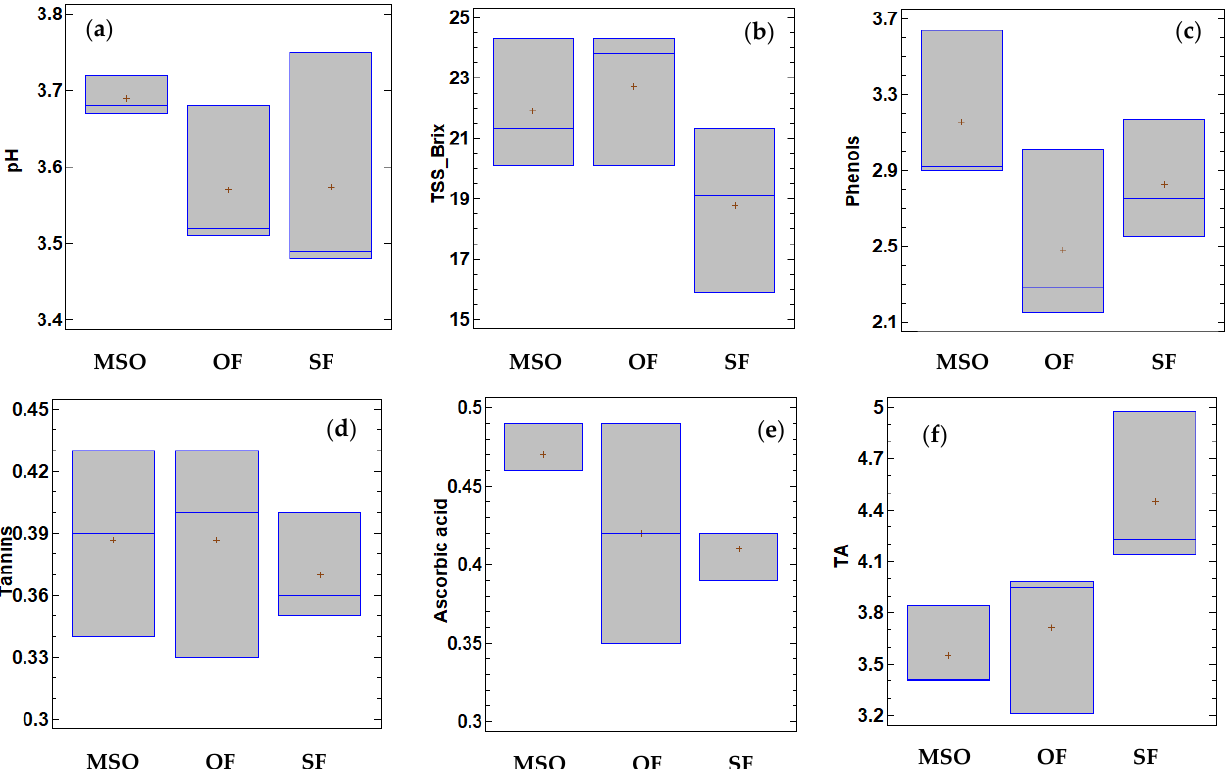
Figure 3. Grape qualitative characteristics for the three treatments. ( a ) pH, ( b ) Total Soluble Solids—TSS (°Brix), ( c ) Total phenolic content (g GAE g −1 fw), ( d ) condensed tannins (g L −1 ), ( e ) Ascorbic acid (mg AA/100 mL), ( f ) Titratable Acidity—TA (g tartaric L −1 ). MSO, OF, and SF are the three treatments. Treatment MSO (mix synthetic and organic fertilizer), OF (organic fertilizer), SF (synthetic fertilizer).